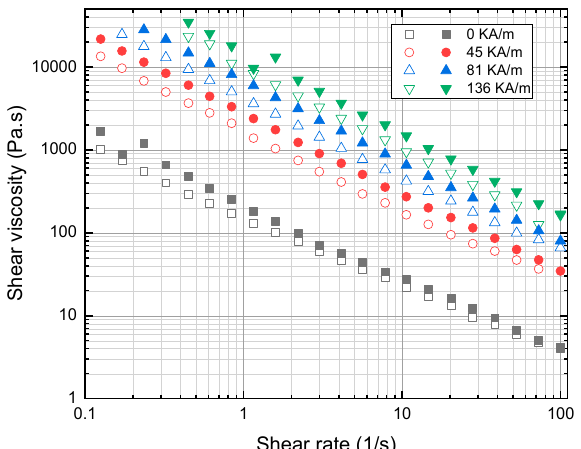
Figure 5. Shear viscosity as a function of shear rate for sunflower (open symbol) and cottonseed oil (closed symbol) blend-based MR fluid subjected to variable magnetic field i.e., 0, 45, 81 and 136 kA/m.